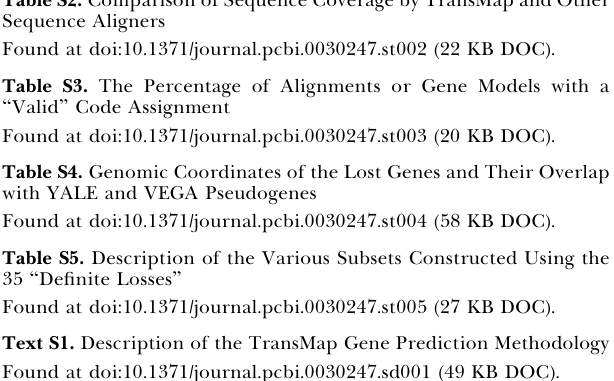
Table S1. Evaluation of the TransMap Gene Model Classifications against ENCODE Gene Annotations Table S2. Comparison of Sequence Coverage by TransMap and Other Sequence Aligners Table S3. The Percentage of Alignments or Gene Models with a ‘‘ Valid ’’ Code Assignment Table S4. Genomic Coordinates of the Lost Genes and Their Overlap with YALE and VEGA Pseudogenes Table S5. Description of the Various Subsets Constructed Using the 35 ‘‘ Definite Losses